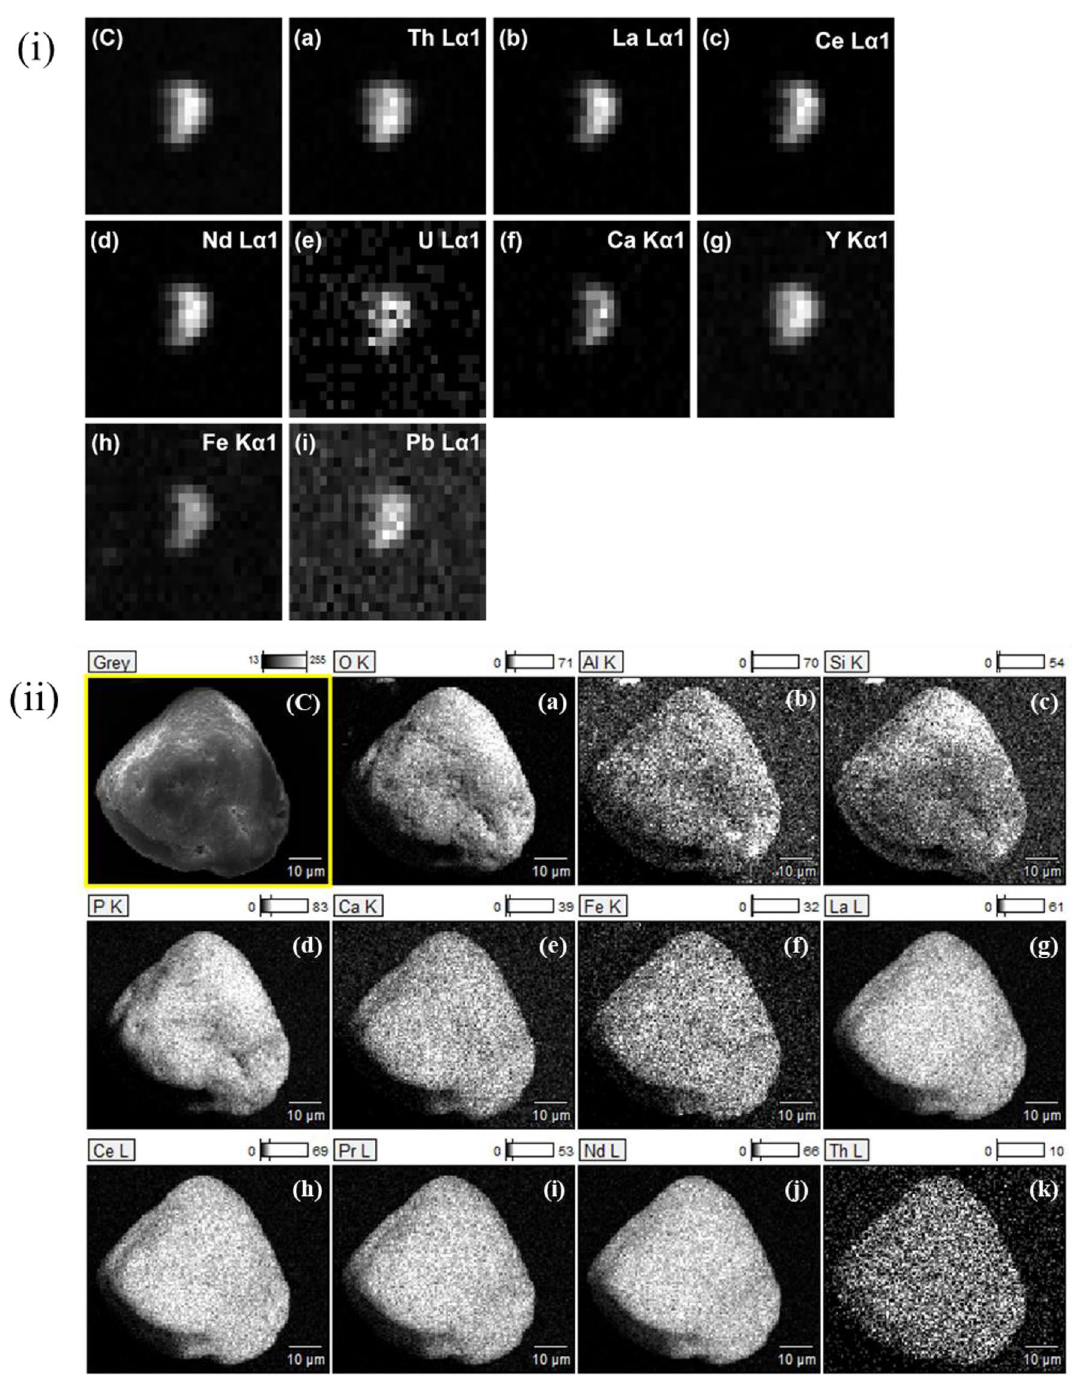
Figure 5. (i) µ-XRF maps of the Th-REE-phosphate particle ( C ) showing the total fluorescence and the fluorescence lines of Th ( a ), La ( b ), Ce ( c ), Nd ( d ), U ( e ), Ca ( f ), Y ( g ), Fe ( h ), and Pb ( i ) in greyscale (maps: 280 µm in width, 183 µm in height). (ii) SEM image of particle C and SEM–EDX elemental maps for O, Al, Si, P, Ca, Fe, La, Ce, Pr, Nd, and Th ( a–k ) of the Th-REE-phosphate particle in Th, Pb, Ca, and U show positive skewness of the data distribution (see Supplementary Fig. S3 online). All of these observations suggest that monazite-type minerals may exist in a variety of compositions, in accordance with EXAFS observations. This observation is further confirmed by the work of Seydoux-Guillaume et al. 42 who studied low-temperature alteration of Sri Lankan monazite samples (exact locality is unknown). We also observed REEs in mixed phases, as the SEM–EDX maps (Fig. 5(ii)C and 5(ii)a-k) for the REEs and P suggest a uniform distribution of each of these elements over the particle (Fig. 5(ii)d and g-j). A uniform distribution of Th over the particle is suggested by the EDX map (Fig. 5(ii)k). Figure 5(ii)b and c could point to the presence of Si/Al